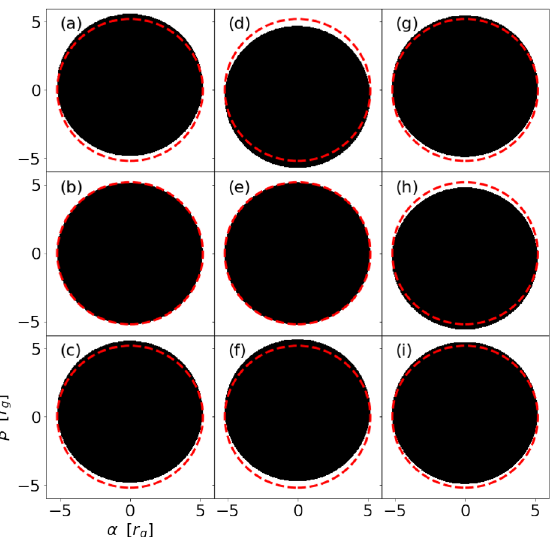
Figure 6 . Example black hole shadows with soft hairs. The dashed (red) circle is the boundary of the shadow of the Schwarzschild black hole, of which the radius is can be shifted in vertical direction. The same inclination angle (but for different perturbation mode and amplitude) is applied for each row, and the corresponding parameters for these shadows can be found in figure 8 according to the labels (a)-(i). Case (b) corresponds to the Schwarchzschild case ( E = 0 ). Note that the shadow for case (e) accidentally coincides with that of Schwarzschild case even if E = 1